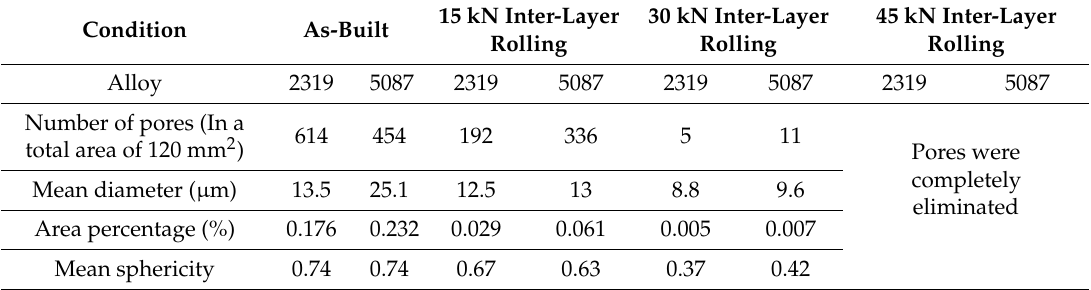
Table 2. Analysis results of pores for various stated WAAM 2319 and 5087 alloys [23]. Condition As-Built